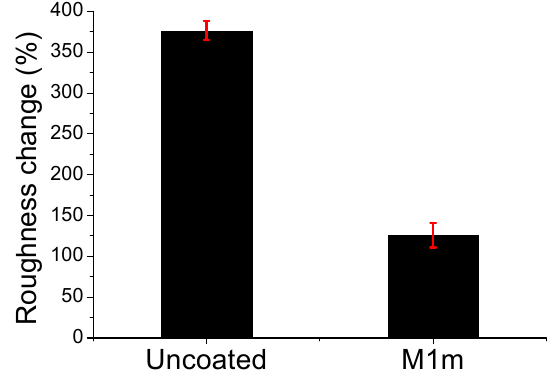
Figure 11. Change of roughness (%) in respect to the original concrete roughness of the coated (by M1m) and the uncoated concrete specimens, sprayed with sulfuric acid solution (4 M) by using daily 17% of the respective reaction’s stoichiometry. The bar charts and the red error bars denote the mean and the standard deviation, respectively.